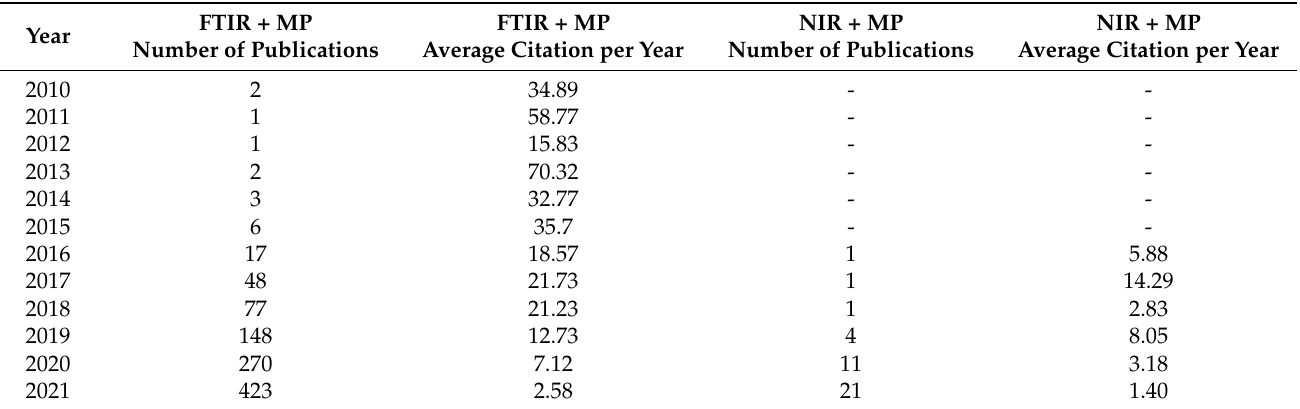
Table 2. Average number of citations received by analysis of MPs with FTIR and NIR papers per